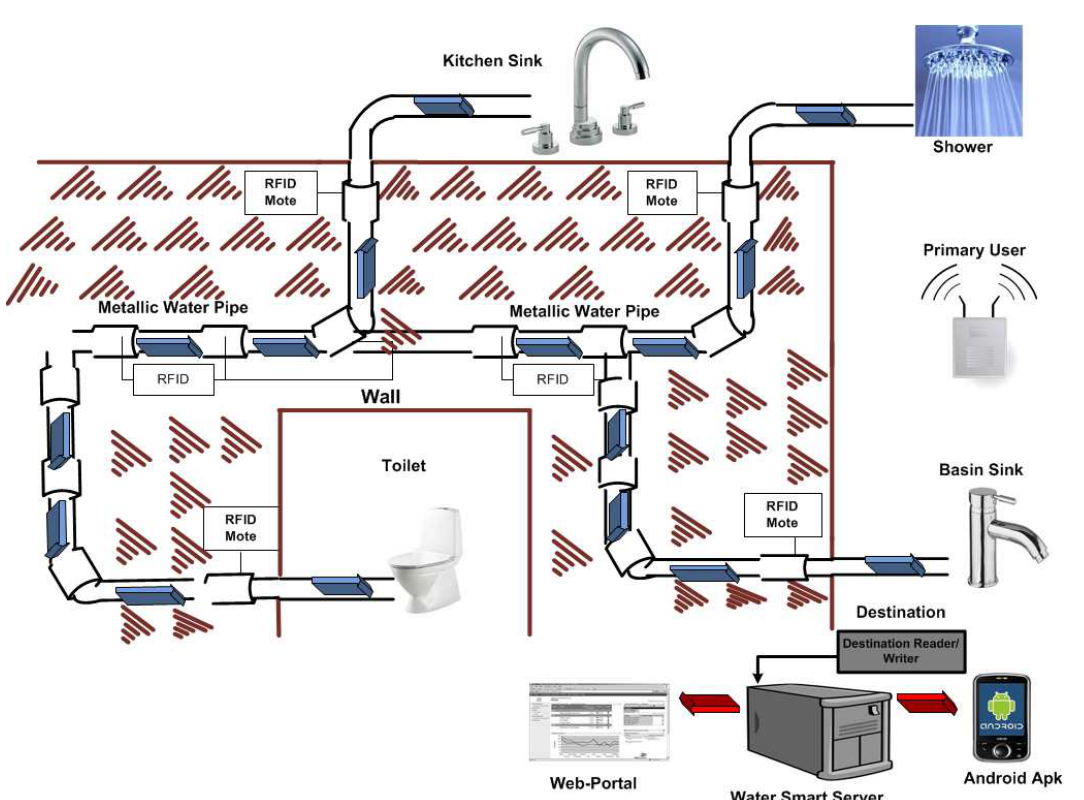
Figure 1. System diagram showing the RFID cognitive nodes, the primary interference and the smart home server as the